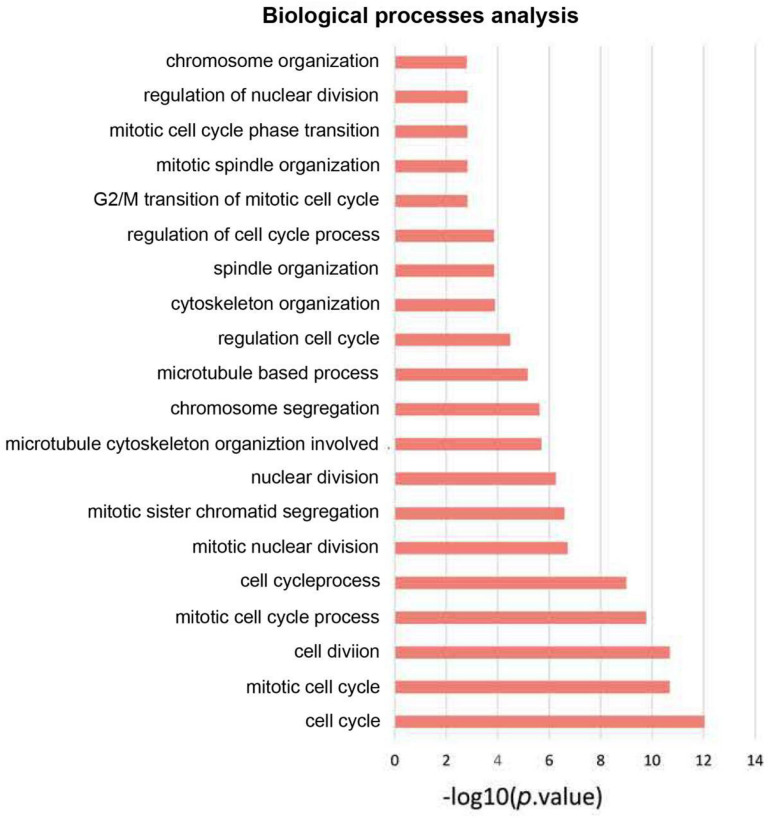
GO enrichment analysis of biological process of aerobic exercise-related DEGs with fold change >2.